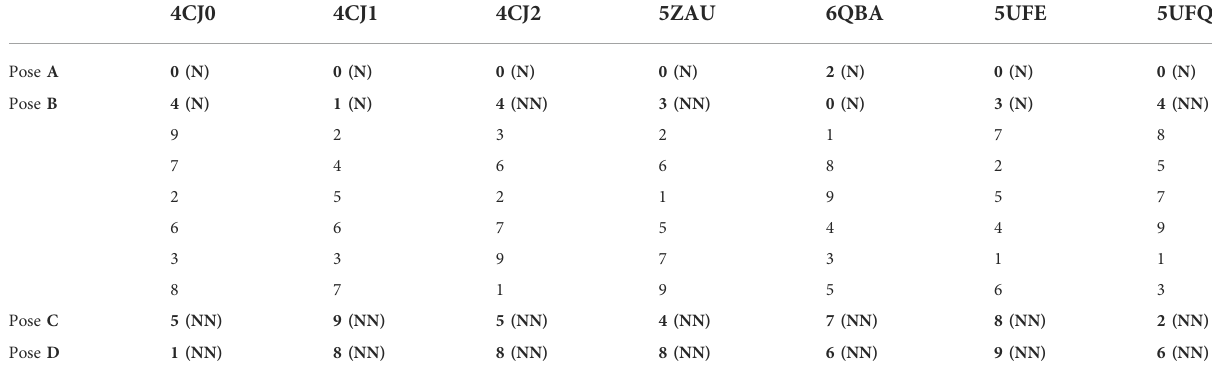
TABLE 2 Reranking of the fi rst ten docking